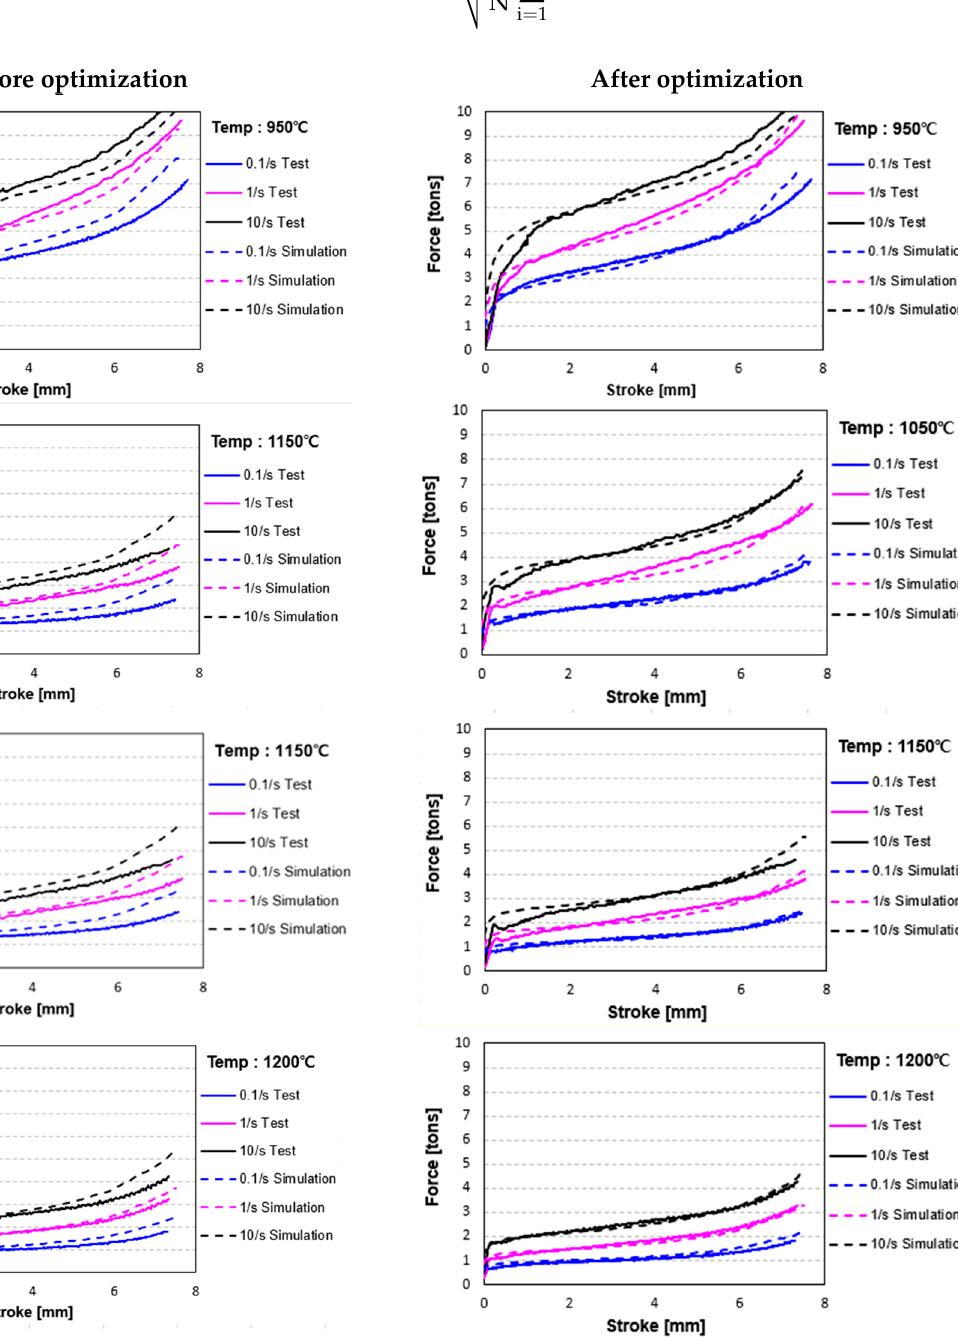
Figure 11. Comparison of experimental and analysis results before and after optimization: ( a ) 950 °C, ( b ) 1050 °C, ( c ) 1150 °C, and ( d ) 1200 °C.